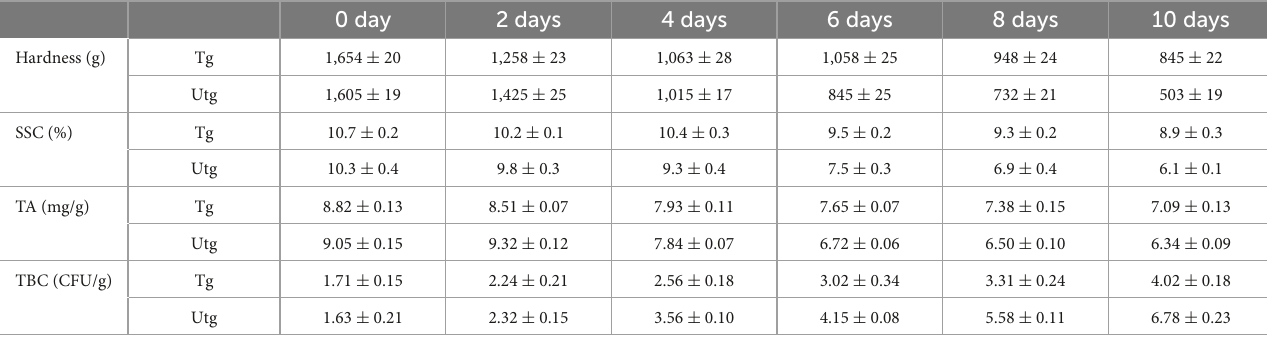
TABLE 3 Perilla essential oil microcapsules (PEOM) on preservation of peach. 0